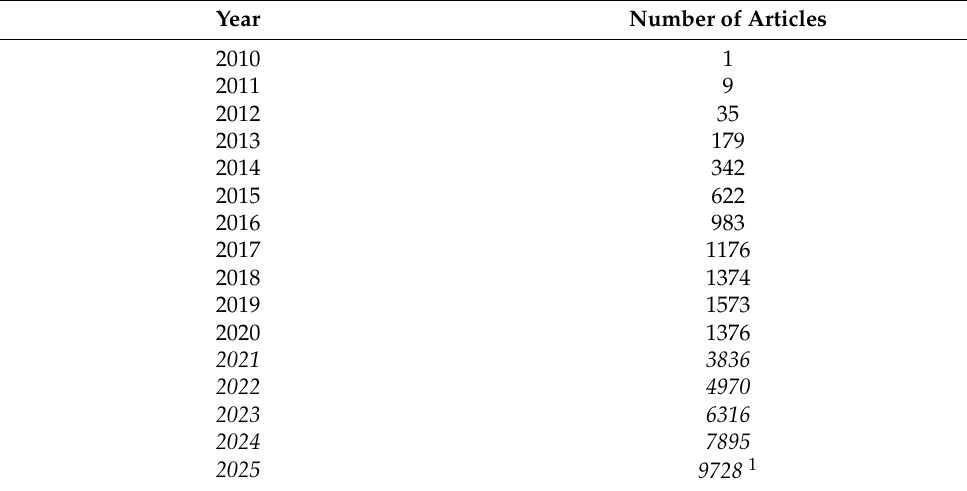
Table 2. Summary of the number of articles corresponding to the phrase “big data analytics” in the Scopus database in 2010–2020 along with the prediction of the number of articles in